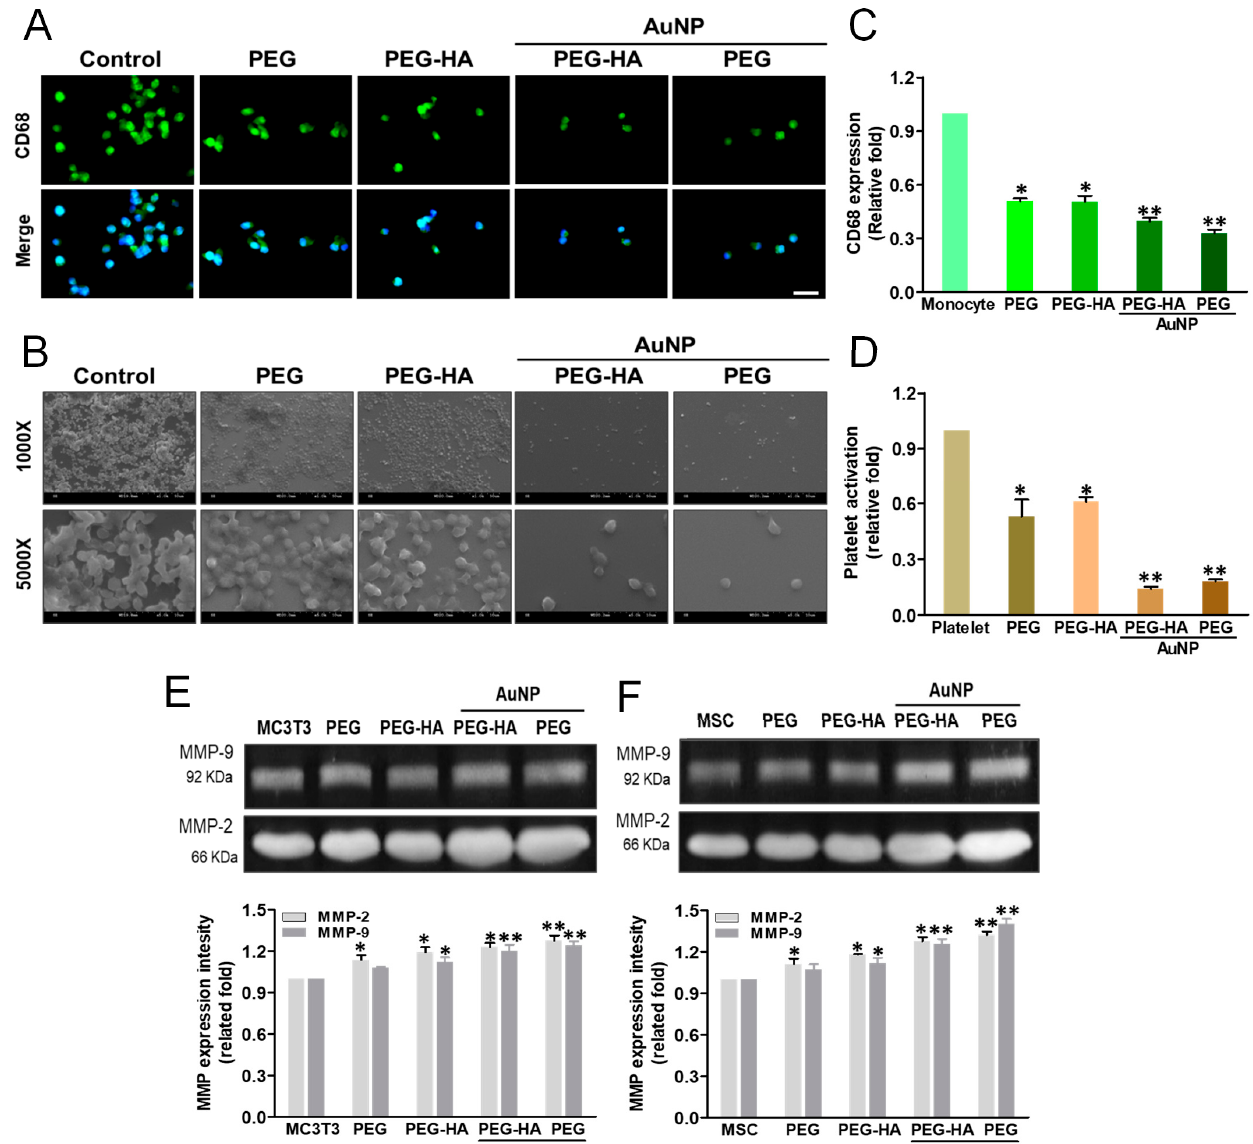
Figure 6. Biocompatibility assay. ( A ) The expression of CD68 for macrophages on different materials at 96 h. Cells were immunostained by the primary anti-CD68 antibody and conjugated with the FITC-immunoglobulin secondary antibody (green color fluorescence). Cell nuclei were stained by DAPI (blue color fluorescence). Scale bar = 20 µ m. ( B ) SEM images showing the adhesion and activation of human blood platelets on different materials. ( C ) CD68 expression was quantified based on fluorescence intensity. * p < 0.05: smaller than control (TCPS). ( D ) Quantification of the degree of platelet activation score. Data are the mean ± SD ( n = 3). * p < 0.05; ** p < 0.01: smaller than control (TCPS). The MMP-2/9 enzymatic activity of ( E ) MC3T3 cells and ( F ) MSCs was increased in the PEG-HA-AuNP and PEG-AuNP groups. Semi-quantitative measurement of MC3T3 cells and MSCs shows the expression level of MMP-2/9 protein for cells on different materials after 48 h of incubation. Semi-quantitative data in the graph represent the optical density (OD) of gelatinolytic bands. Data are the mean ± SD ( n = 3). * p < 0.05; ** p < 0.01: greater than control